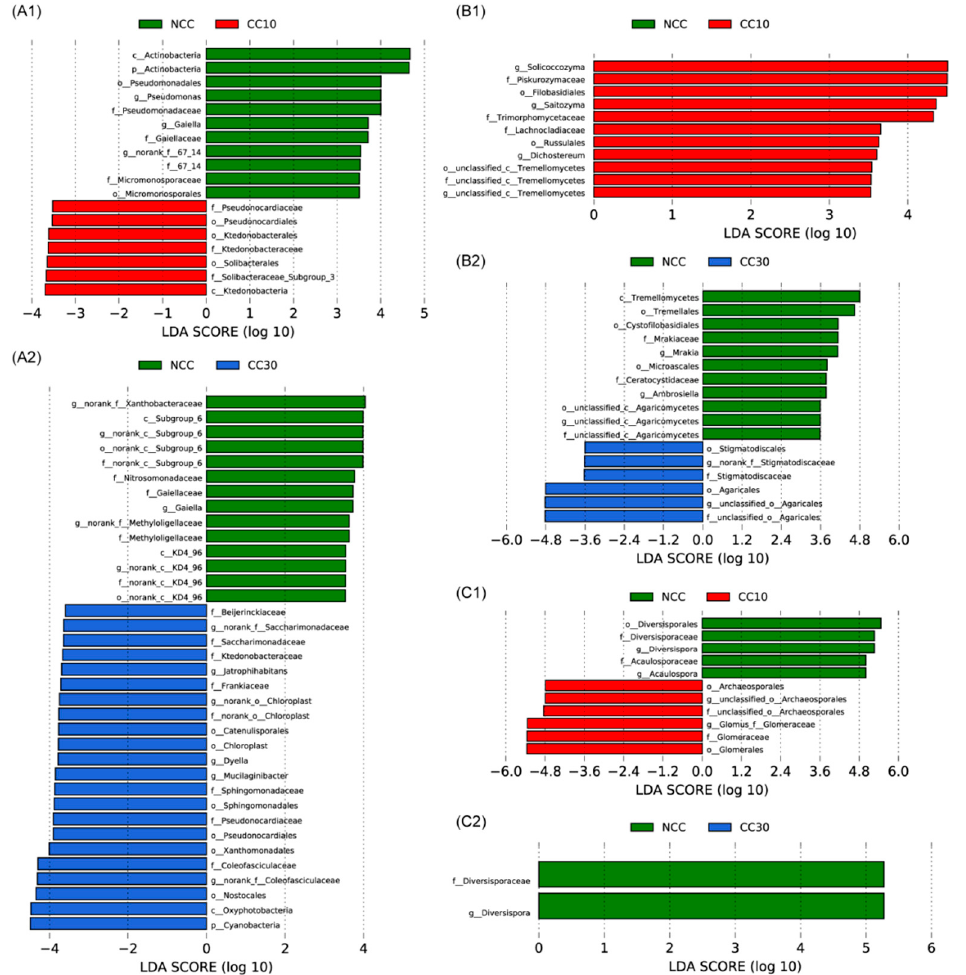
Figure 3. Liner discriminant analysis, in conjunction with effect size measurements, identifies the differentially abundant taxa between cultivation years: NCC vs. CC10/CC30 of bacterial ( A 1, A 2), fungal ( B 1, B 2), and AM fungal taxa ( C 1, C 2). Lineages with LDA values greater than 3.5 are shown.